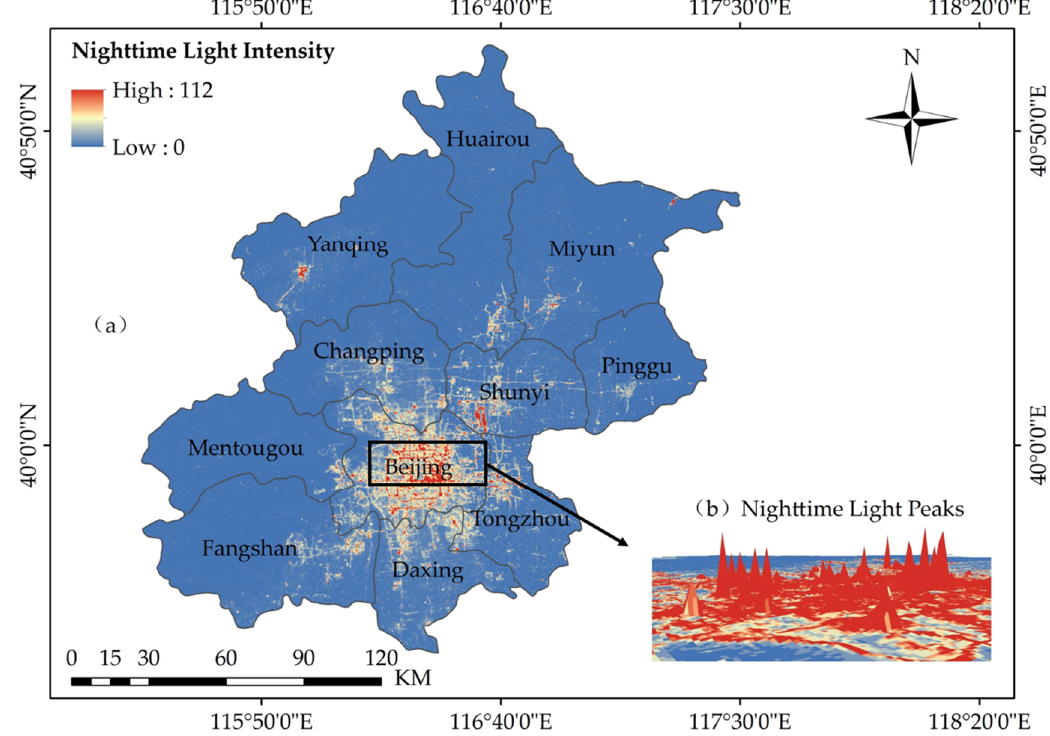
Figure 2. ( a ) Luojia-1 nighttime light (NTL) intensity map of Beijing. ( b ) Three-dimensional (3D) view of the NTL peaks in the urban core area.